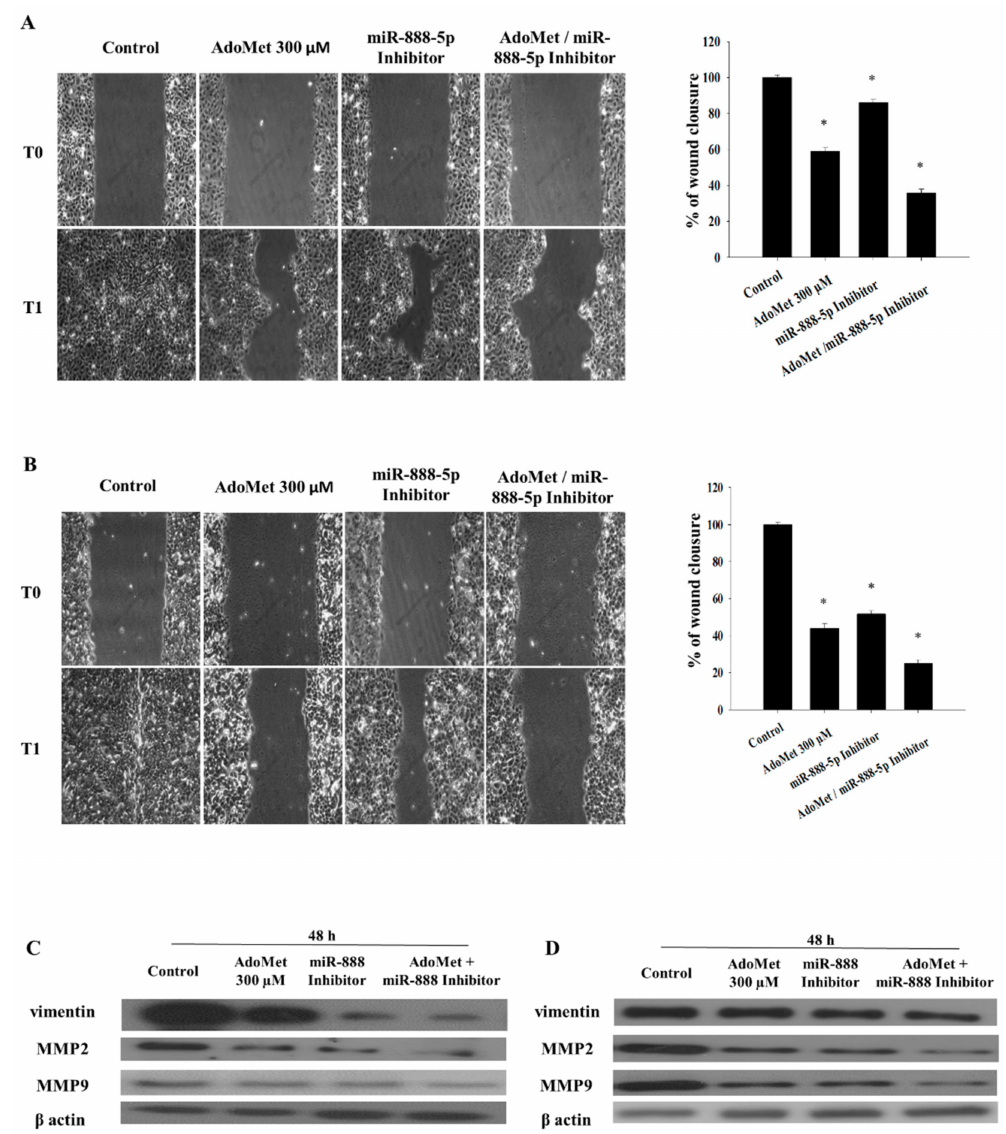
Figure 5. E ff ect of AdoMet and miR-888-5p inhibitor combination on cell migration in LSCC. Confluent monolayers of ( A ) JHU-SCC-011 and ( B ) HNO210 cells treated or not (Control) with 300 µ M AdoMet and miR-888-5p-inhbitor alone or in combination for 48 h, were scratched with a micropipette tip and snapshot pictures were captured by microscope to check for wound closure. Pictures of the wounds corresponding to time zero (T0) and 24 h (T1) from the scrape in both cell lines are reported. Histograms show the quantification of wound area calculated as a percentage of the control using Image J software (U.S. National Institutes of Health, Bethesda, MD, USA). Data represent the average of three independent experiments. The means and SD are shown. * p < 0.05 versus control. The expression levels of vimentin, MMP2 and MMP9 were detected by Western blot analysis using the total cell lysates of ( C ) JHU-SCC-011 and ( D ) HNO210 cells. For the equal loading of protein in the lanes, β -actin was used. The images are representative of three immunoblotting analyses obtained from at least three independent experiments. Uncropped images of Western blots are reported in Figure